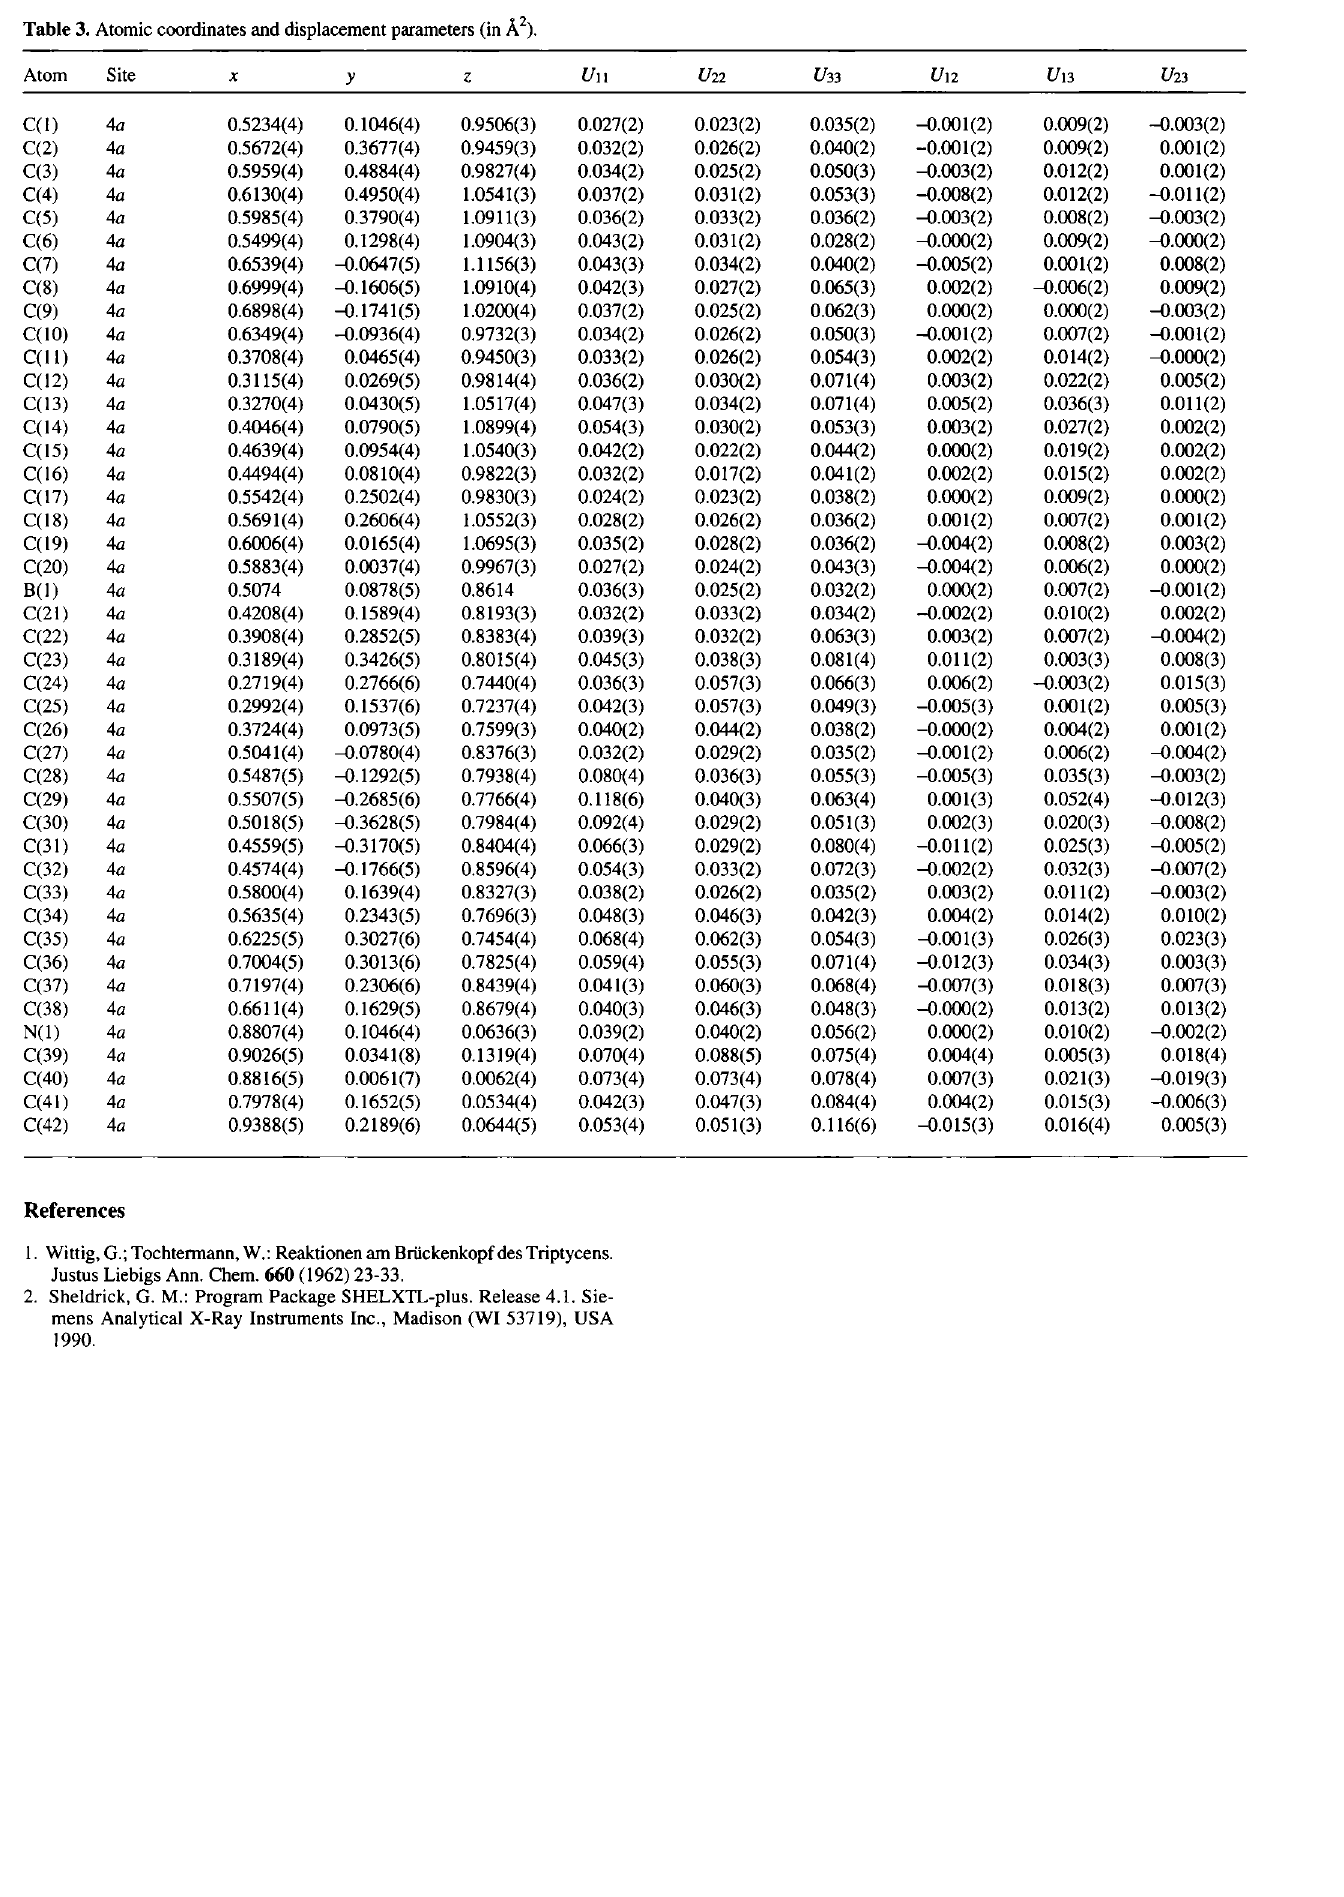
Table 3. Atomic coordinates and displacement parameters (in Â 2